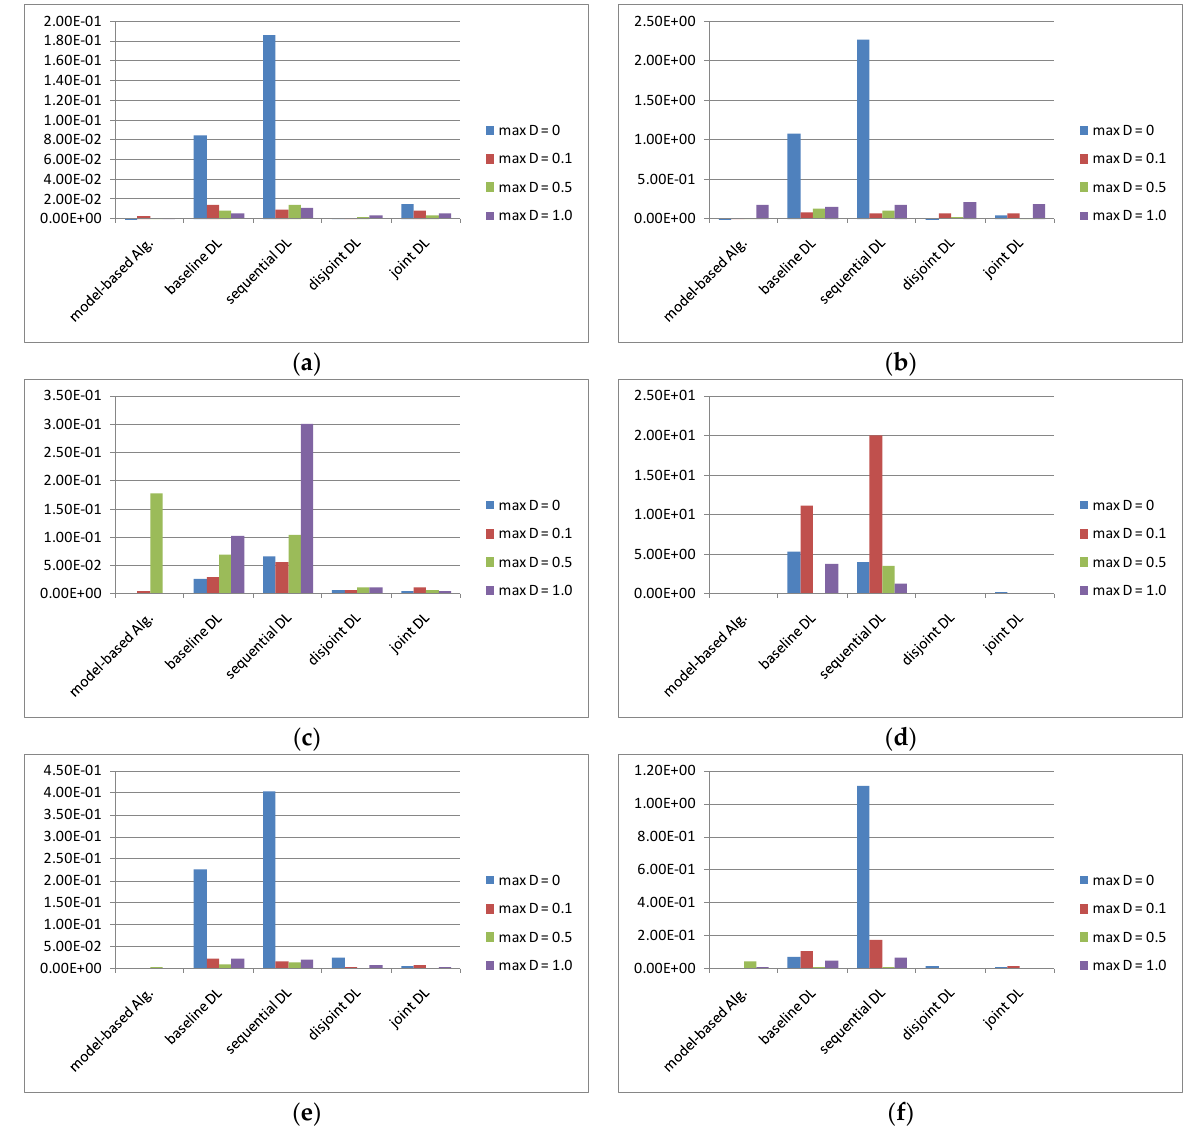
Figure 4. The mean square of disagreement of the proposed DL consensus algorithm trained with large delay train data (max D is the maximum delay τ max ) ( a ) case 1; ( b )case 2; ( c )case 3; ( d )case 4; ( e )case 5; ( f ) case 6.